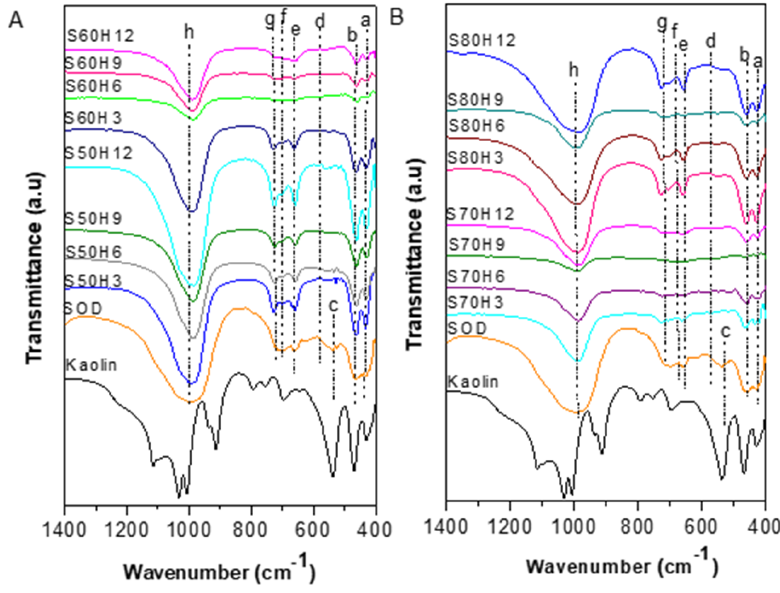
Figure 2. FT-IR (Fourier transform infrared) analysis of samples with various crystallization times and temperatures of ( A ) 50–60 °C and ( B ) 70–80 °C. Table 3. Wave number IR spectrum of synthesized